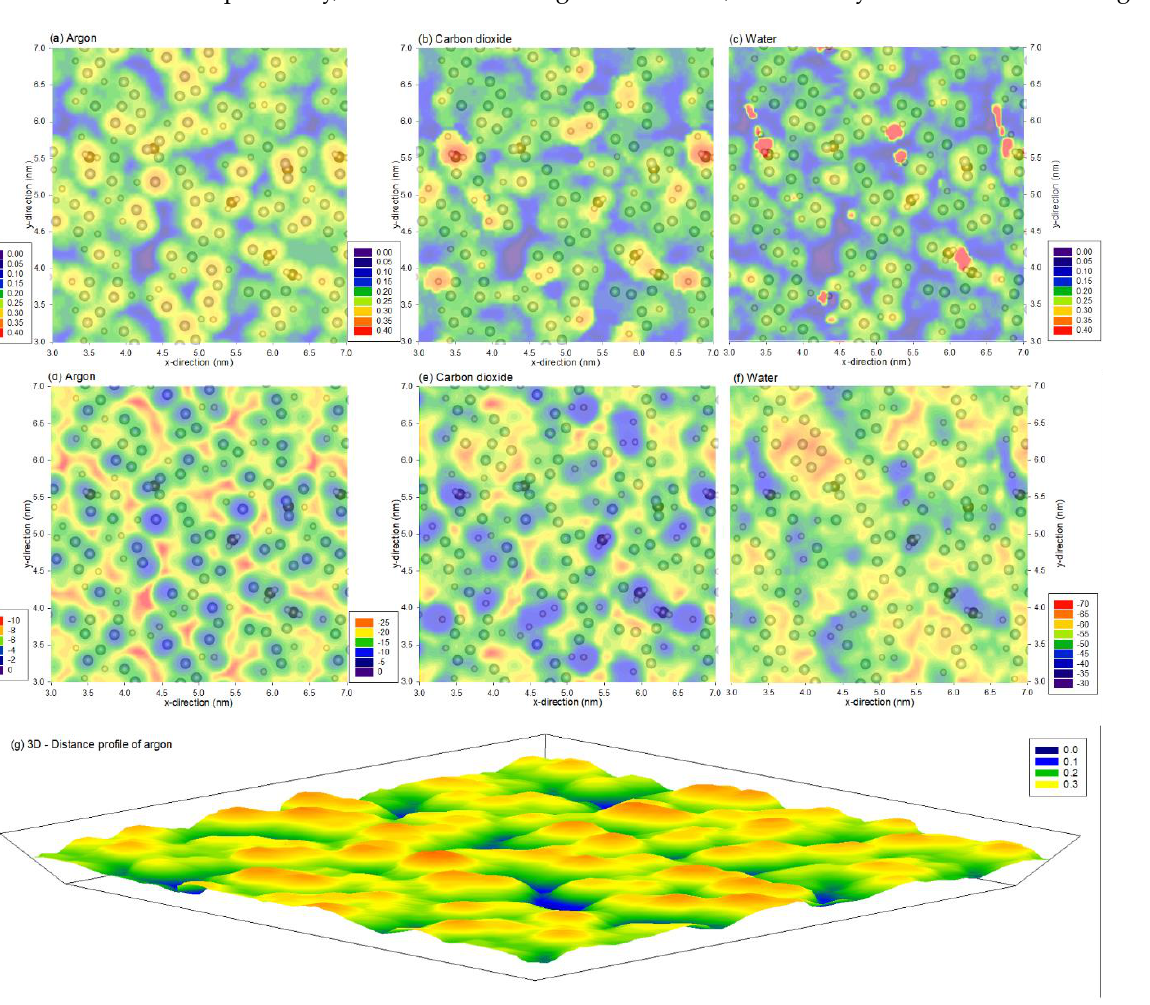
Figure 2. ( a , b ) distance of the probe molecule at the ( d – f ) minimum total interaction energy between ( a , d ) argon ( b , e ) carbon dioxide and ( c , f ) water molecules and the PVDF membrane. Note that the profiles are superimposed with PVDF atoms from the top 0.1 nm of the membrane, and the range for the legends are different, represented in ( a – c ) nm and ( d – f ) kJ/mol. ( g ) represents ( a ) in three-dimensional form.